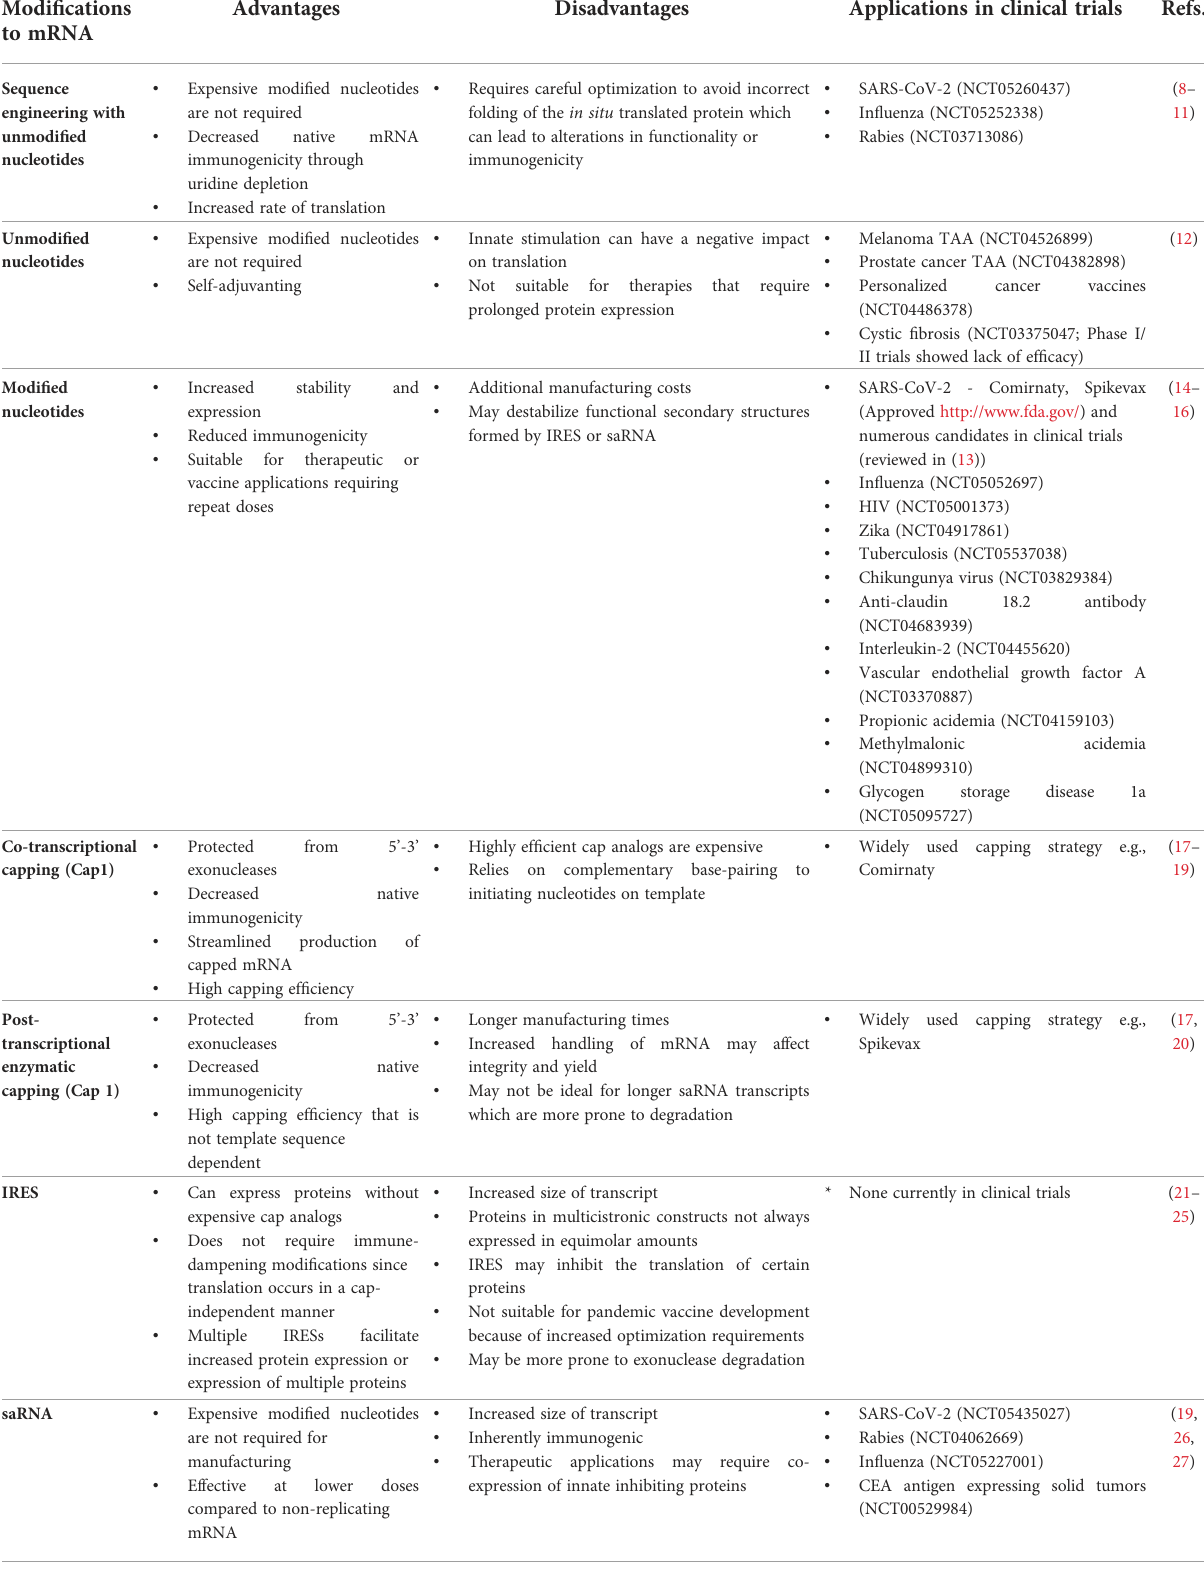
TABLE 1 Advantages and disadvantages of key modi fi cations to in vitro transcribed mRNA, with selected examples of applications in clinical trials. Modi fi cations Advantages Disadvantages Applications in clinical trials to mRNA